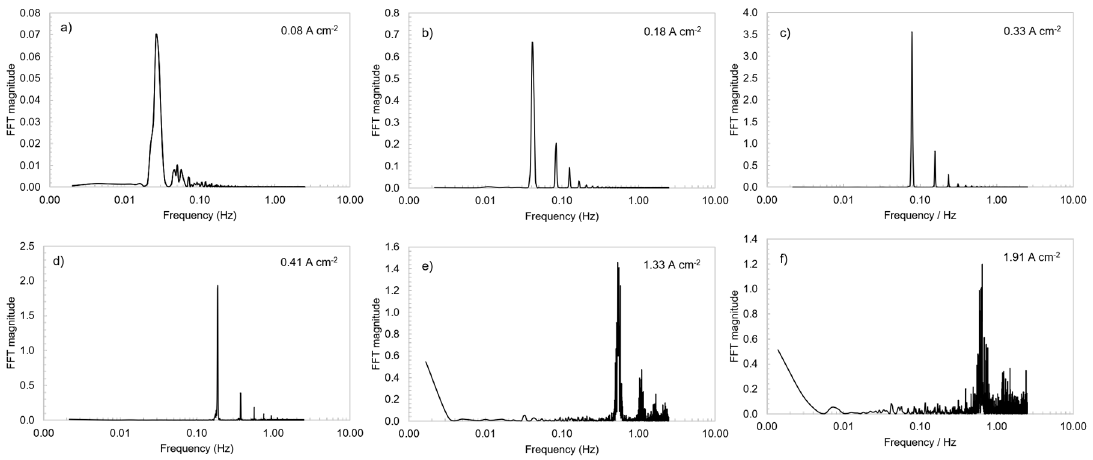
Figure A1. FFT spectrum of the current density–time data for the horizontal anode at different applied potentials. The current densities in the figure are the current densities measured in the moment the bubble has detached from the anode surface (i.e., the current obtained for the bubble-free surface): ( a ) 0.08 A cm − 2 , ( b ) 0.18 A cm − 2 , ( c ) 0.33 A cm − 2 , ( d ) 0.41 A cm − 2 , ( e ) 1.33 A cm − 2 , and ( f ) 1.91 A cm − 2 .